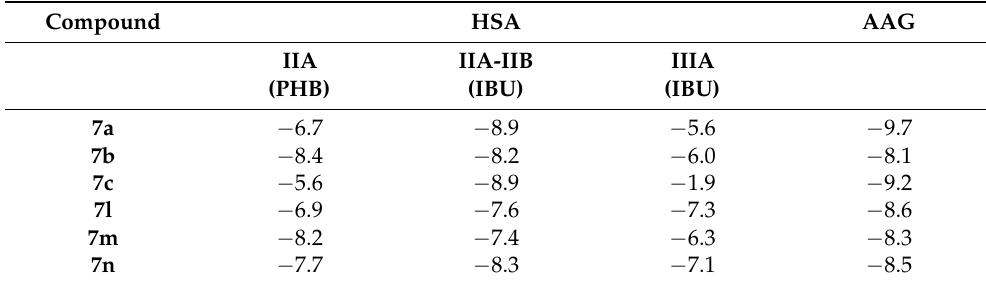
Table 15. The binding affinity (kcal/mol) for interaction compounds 7a – 7c and 7l – 7m with human serum albumin (HSA) and alpha-1-acid glycoprotein (AAG). Compound HSA AAG IIA